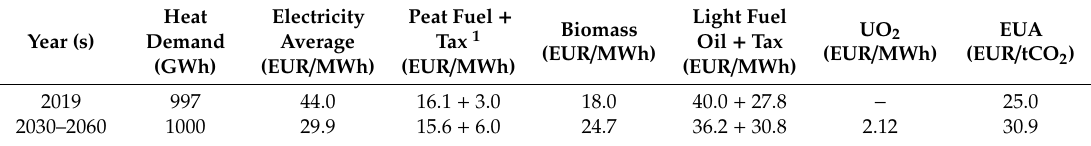
Table 2. Price of electricity and fuels for simulated powerplants [9,20,30–33].